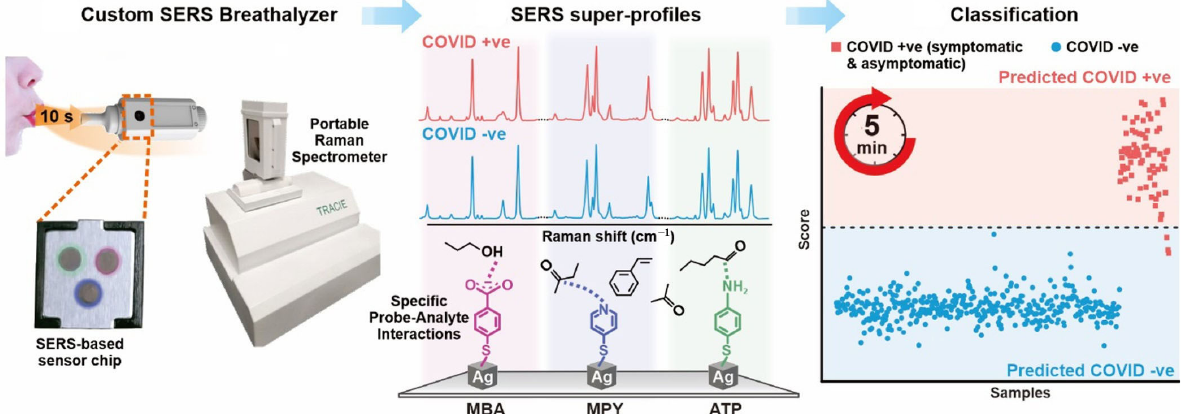
Figure 12. Schematic diagram of using respiratory volatile organic compounds (BVOCs) to identify COVID-19-positive based on plasmonic biosensing. Reproduced with permission from reference [100]. Copyright 2022 American Chemical Society.